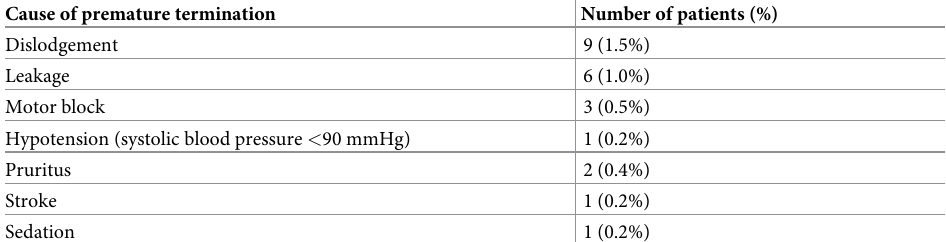
Table 3. Causes for premature termination of epidural analgesia at the